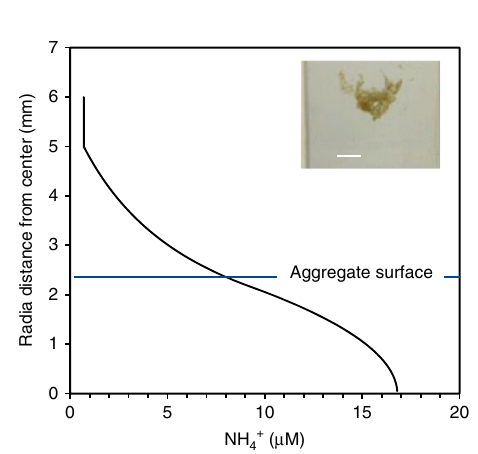
Fig. 6 The radial distribution of ammonium concentrations in sinking diatom aggregates. The concentrations were modeled from the measured ammonium release to the ambient water. An example of such an aggregate is shown in the picture. The white size bar is 3